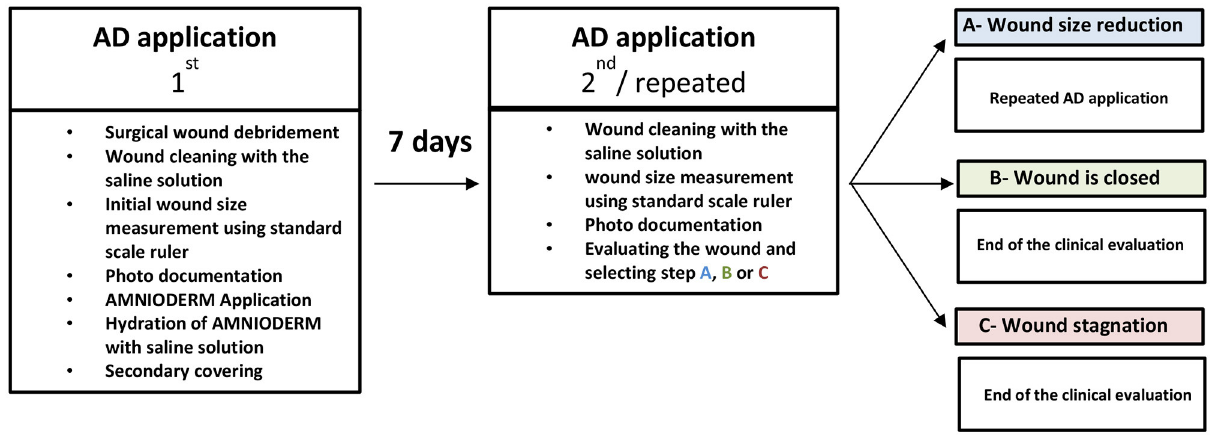
TABLE 2 | Wound management strategy (AD, Amnioderm ®